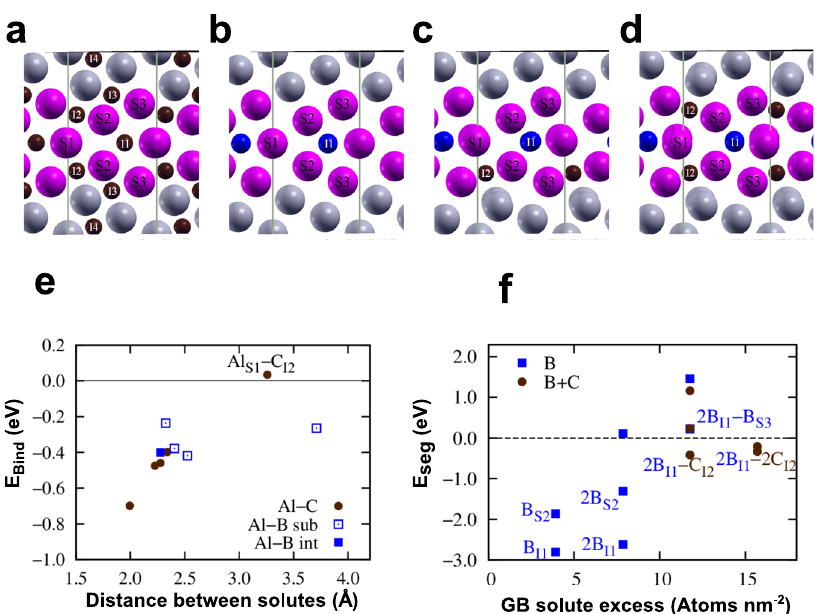
Fig. 9 Solute interactions at GB. a GB structure with labeled substitutional (S1-S3) and interstitial sites (I1-I4). b The GB structure corresponding to con fi guration B I 1 and 2B I 1 (the two B atoms are oriented in [0 0 1] direction and the structure cannot be distinguished from con fi guration B I 1 ). c , d shows the con fi gurations 2B I 1 C I 2 and 2B I 1 2C I 2 . In e , the binding energies of Al with B and with C are shown as a function of the distance between the solutes. Panel f presents the co-segregation energies of B and C atoms to the GB, where important con fi gurations are